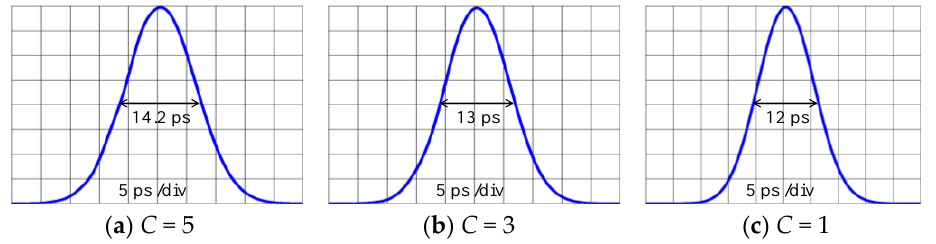
Figure 7. Simulations of the recovered OCDMA auto-correlation envelope S L=19.5;T=50 for OCDMA code propagation distance L = 19.5 km, T = 50 ° C, and C equals to ( a ) 5 resulting FWHM width = 14.2 ps; ( b ) 3 resulting FWHM width = 13 ps; and, ( c ) 1 resulting FWHM width = 12 ps, respectively.